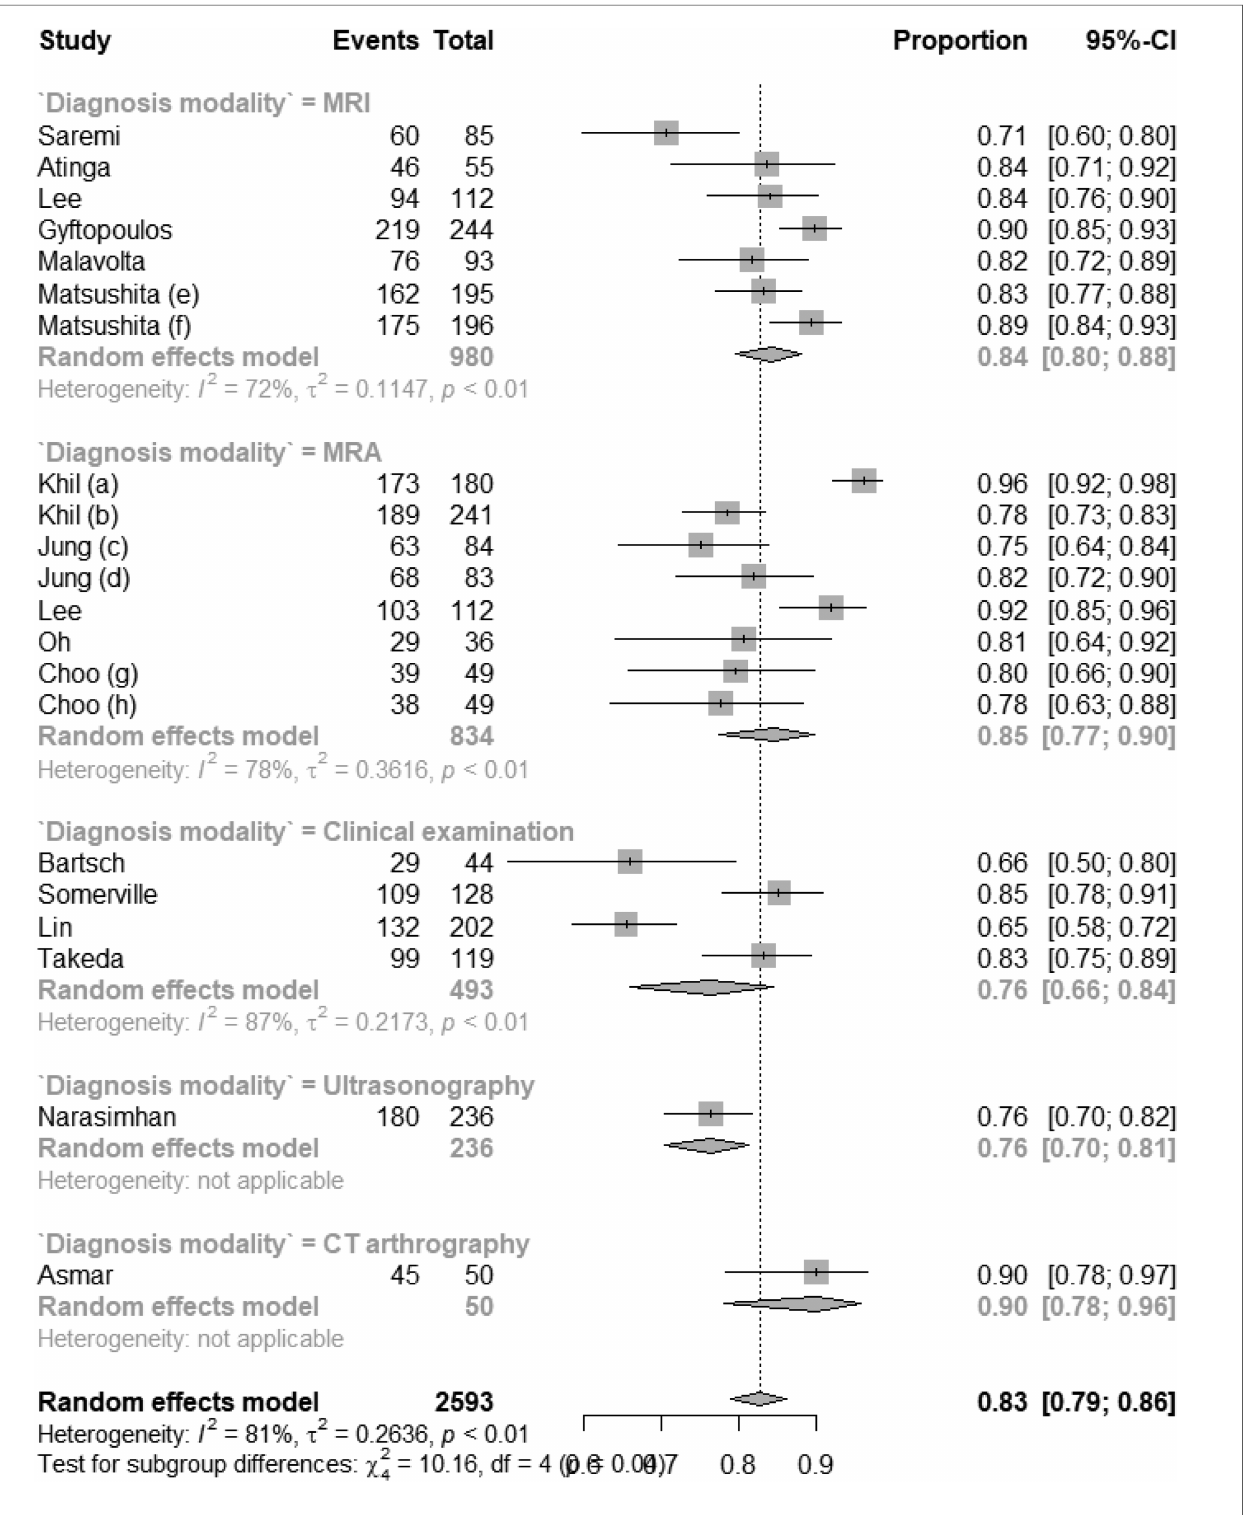
FIGURE 4 Forest plot of diagnostic accuracy of different diagnostic